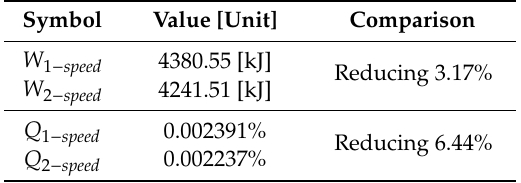
Table 7. Simulation results of different gearboxes under New European Driving Cycle (NEDC)